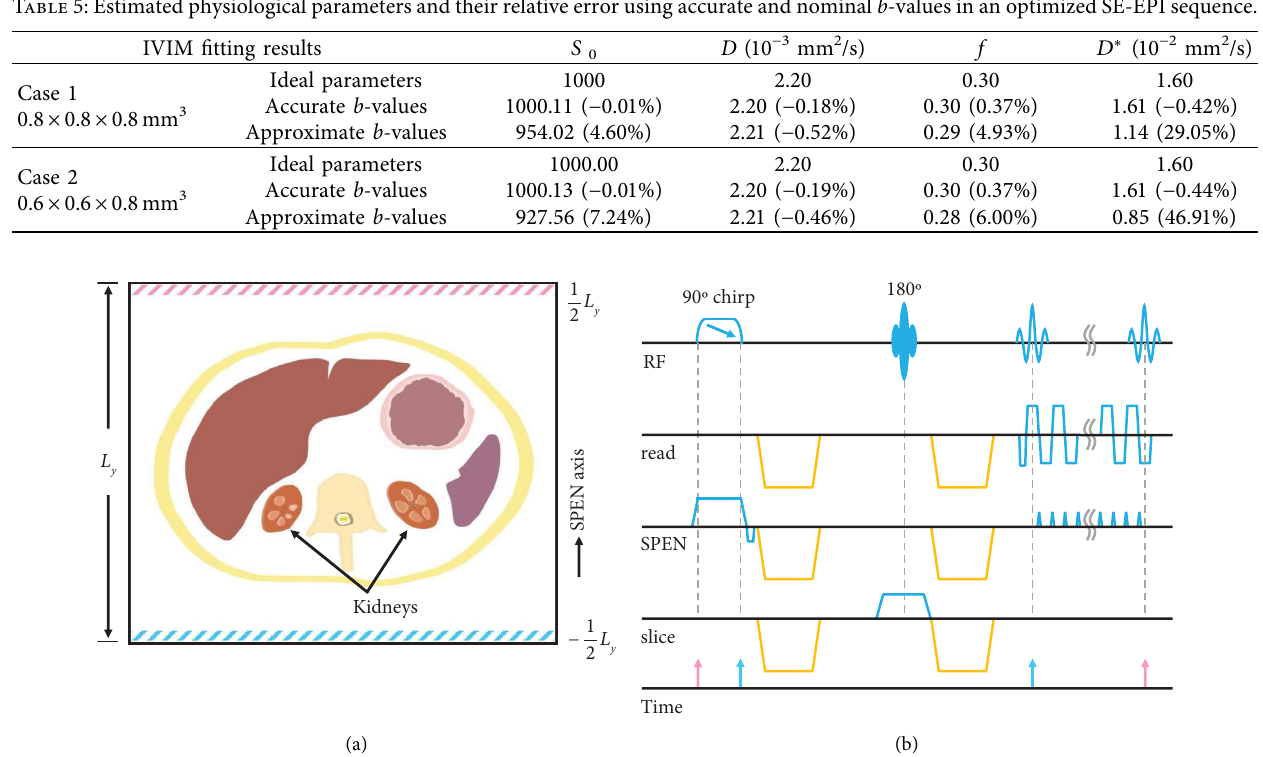
Figure 7: Illustration of an axial sketch of human kidneys (a) and the SPEN sequence (b). Te sequence is designed so that positions at y � ( 1/2 ) L y are excited frst but refocused last, as indicated by the pink arrow. In contrast, the blue arrow indicates that positions at y � − ( 1/2 ) L L y are excited last but refocused frst. y represents the imaging FOV along the SPEN